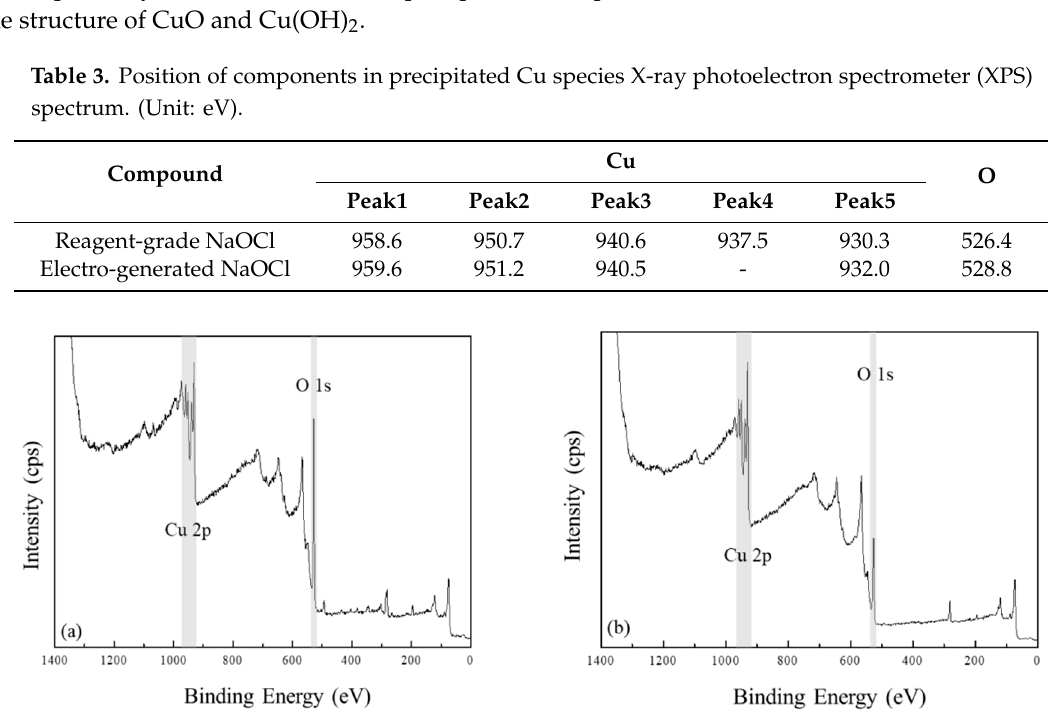
Figure 5. The surface element analysis of the precipitated Cu after reaction with reagent-grade hypochlorite (RGH) and electro-generated hypochlorite (EGH) using XPS. The morphological structure of the precipitated Cu using electro-generated NaOCl and reagent- grade NaOCl were examined by TEM images as well as selected area electron diffraction (SAED) analysis. Figure 6a,b shows that TEM images of the precipitated Cu using electro-generated NaOCl, and it can be seen that precipitates have aggregated to form relatively regular morphologies with uniform diameters of 20 nm. The SAED pattern (inset of Figure 5b) further confirms that the precipitates are amorphous [22]. The TEM images of the precipitated Cu using reagent-grade NaOCl are also shown in Figure 5c,d. The morphological structure shows that smaller nanoparticles were formed together with the nanoellipsoids. The SAED pattern shows apparent diffraction ring and spots (inset of Figure 5d), indicating that the precipitates are of polycrystalline structure [23]. The different particle size was proved that sedimentation rate was quite faster using electro-generated NaOCl than using reagent-grade NaOCl. Hence, the use of electro-generated NaOCl improves the separation efficiency of precipitated Cu.